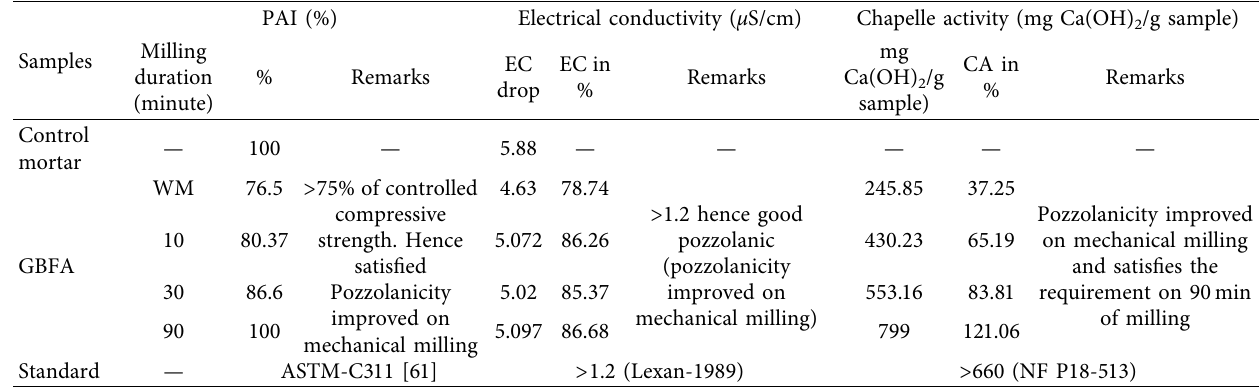
Table 6: Test results of all